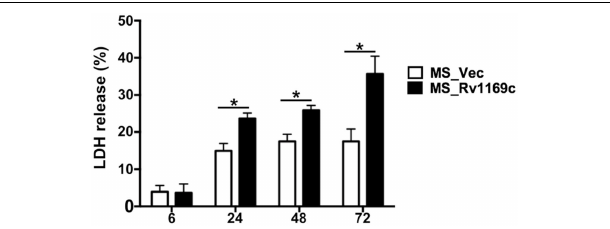
FIGURE 6 | Intracellular survival of recombinant Ms_Vec and Ms_Rv1169c within macrophages. PMA-differentiated macrophages were infected with Ms_Vec or Ms_Rv1169c at an MOI of 10. At 6, 24, 48, and 72h after infection, the macrophages were washed and lysed using 0.01% SDS. Lysates were plated on MB 7H10 medium containing 100 µ g/ml Hyg to determine the bacterial number. * P < 0 . 05 .